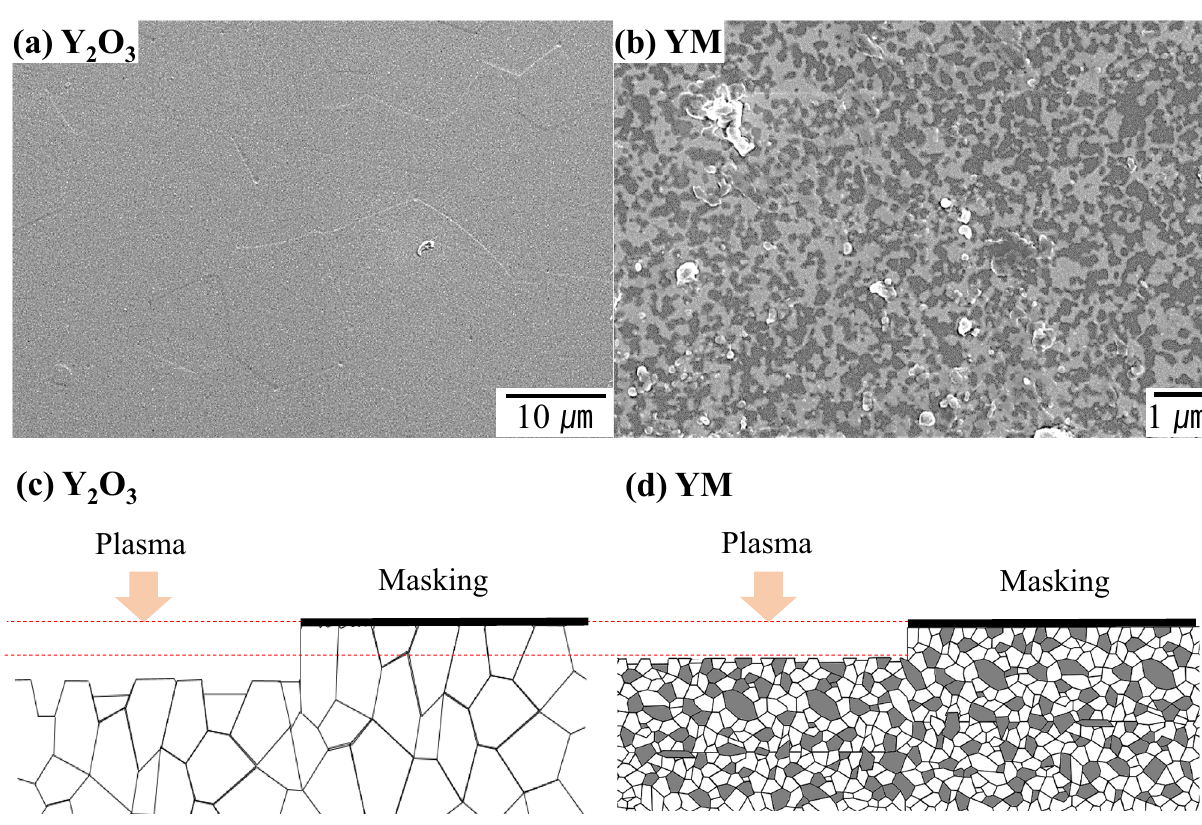
Figure 4. SEM and schematic images of plasma etched surface of ( a , c ) Y 2 O 3 and ( b , d ) YM; (bright grain: Y 2 O 3 , dark grain: MgO).